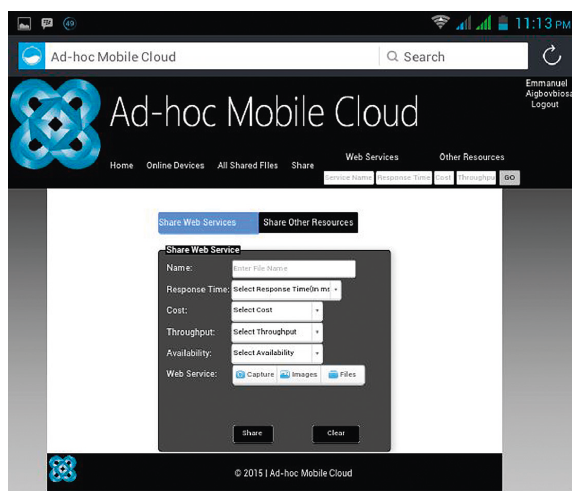
Figure 5: Service specification and query interface.